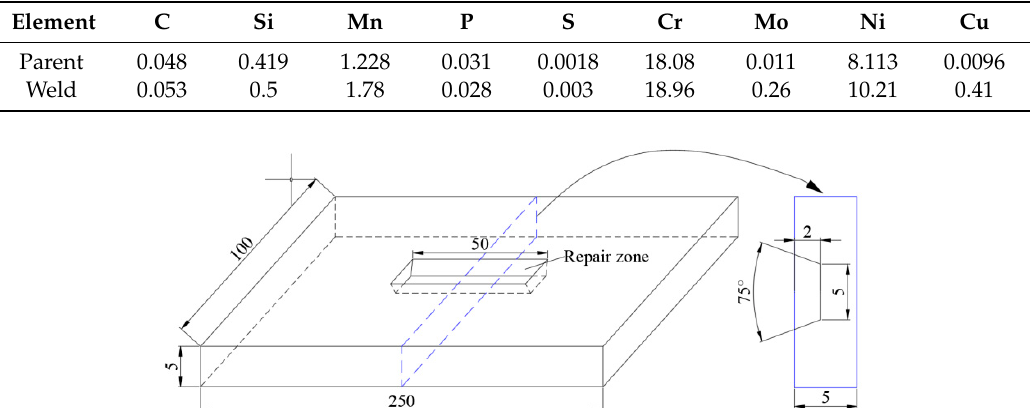
Table 2. Welding parameters of repaired specimens with di ff erent repair